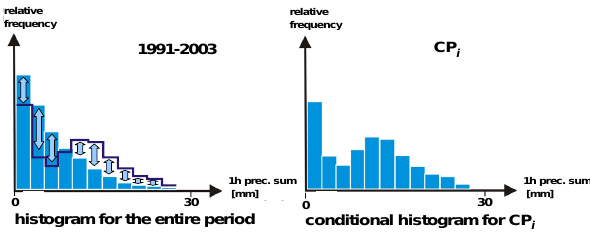
Fig.1. PrincipleoftheobjectivefunctionfortheCPdefinitioninthesimulatedannealingscheme. Fig. 1. Principle of the objective function for the CP definition in the simulated annealing